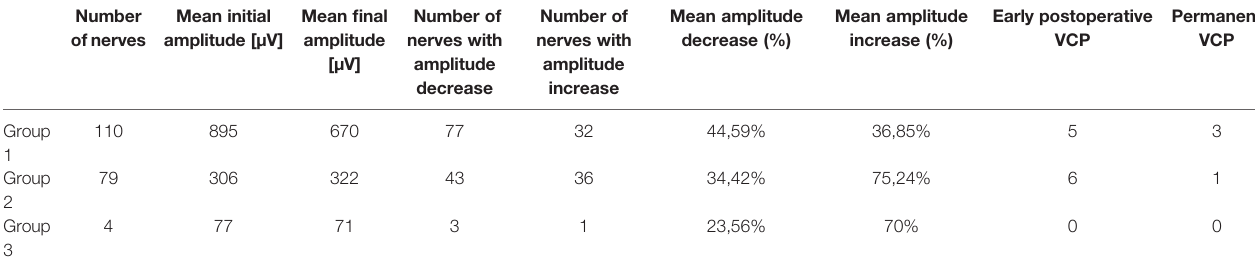
TABLE 1 | Main features of EMG signals for Groups 1, 2, and 3. In Group 1 one nerve had A1=A2. Number